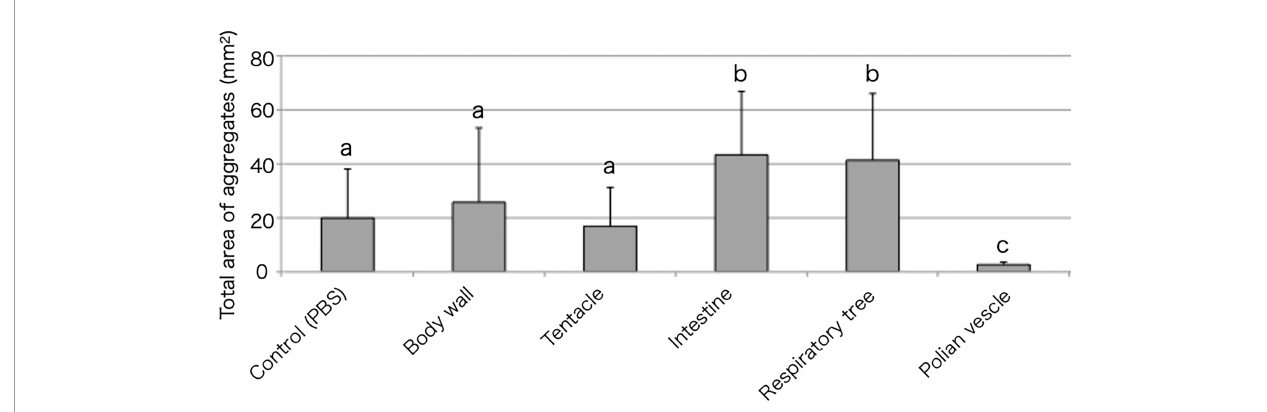
FIGURE 4 | Aggregation-promoting activity of the tissue extracts. Total area of the aggregates, 30 min after the addition of the extracts to the coelomic fl uid. P < 0.05 (mean ± SD, n = 5). Different letters show signi fi